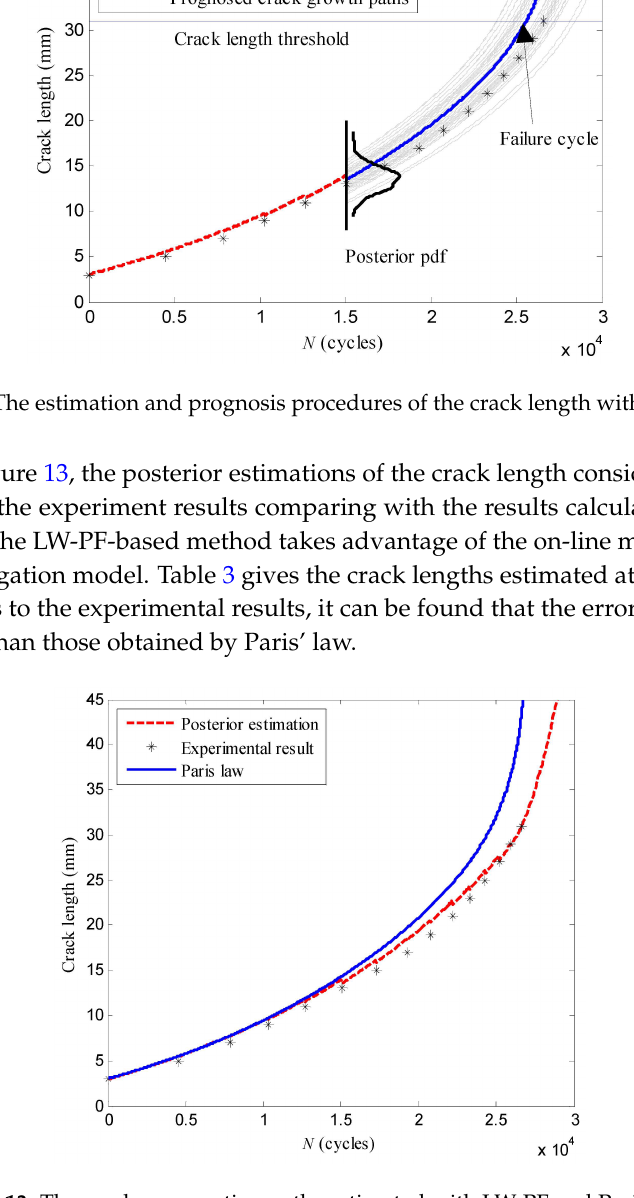
Figure 13. The crack propagation paths estimated with LW-PF and Paris’